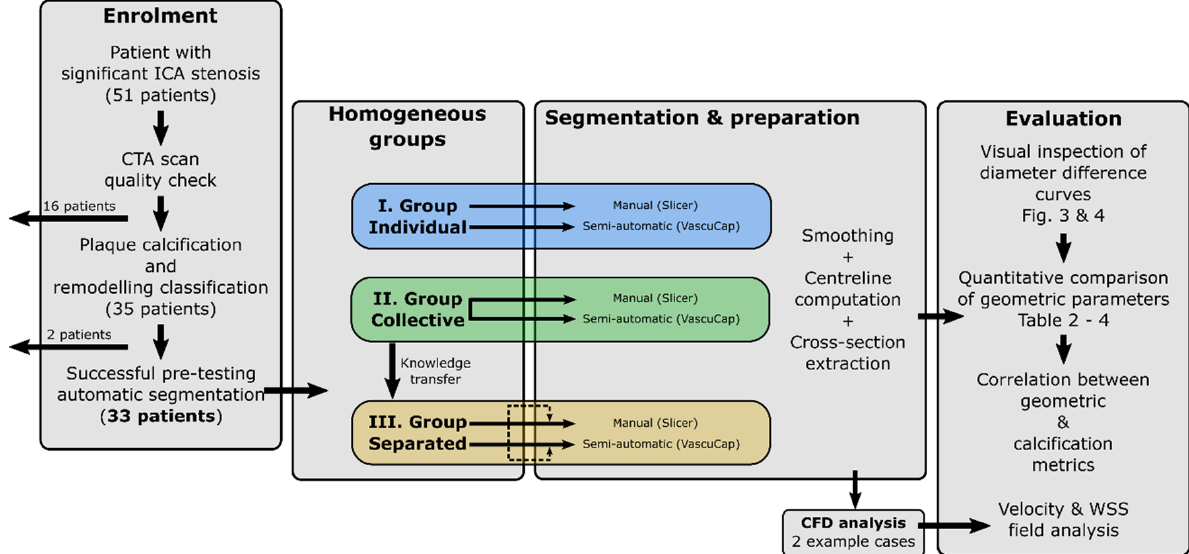
Figure 1. Summary flowchart of the main methodological steps: Patient enrolment including patients excluded from the study, homogeneous grouping, segmentations, and subsequent preparations of the three groups with two methods, CFD analysis of two cases and evaluation of the data. (ICA: Internal carotid artery CFD: Computational fluid dynamics WSS: wall shear stress.